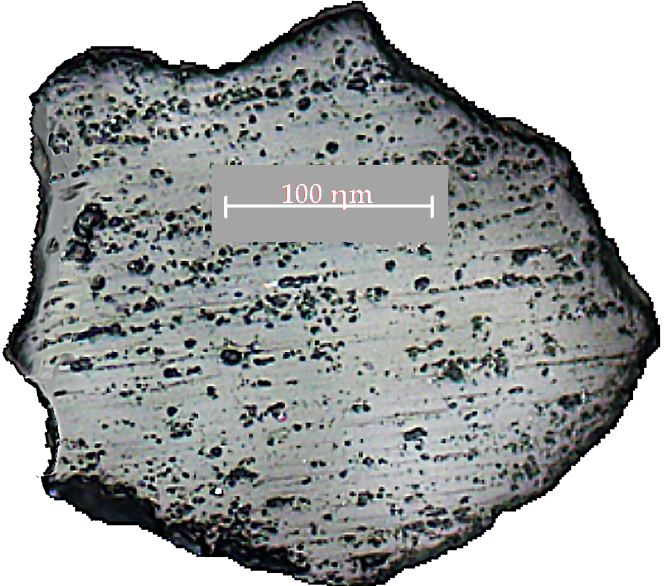
Figure 6. Sand grain micro-specimen from the used liquid glass mixture exposed to long-term outdoor storage.